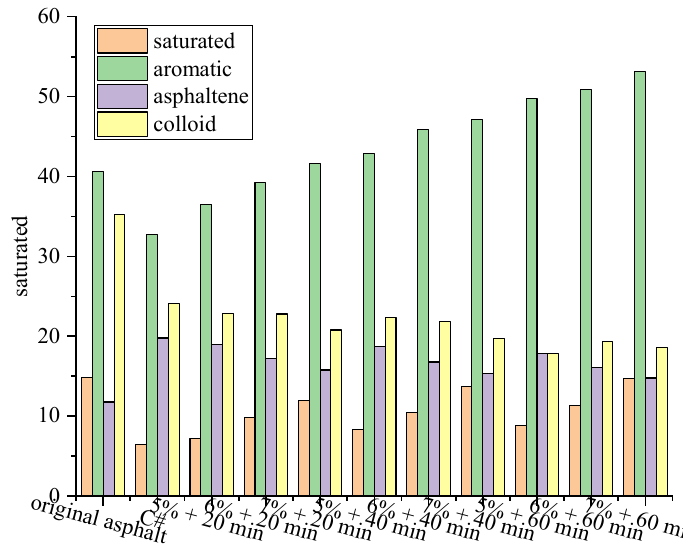
Figure 1. Changes in aging asphalt components. Table 6. Absorption peak range of each